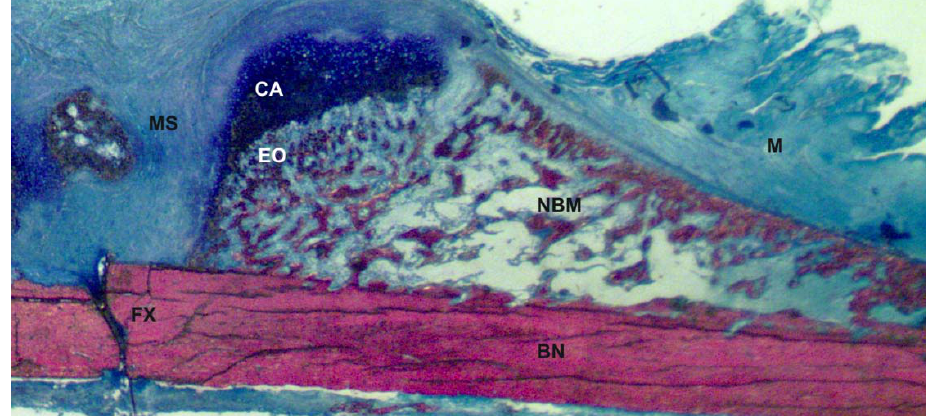
Figure 1. Upper right quadrant of a longitudinal rat fracture femur section, 2-weeks post- fracture. MS = mesenchymal cells, CA = cartilage, EO = site of endochondral